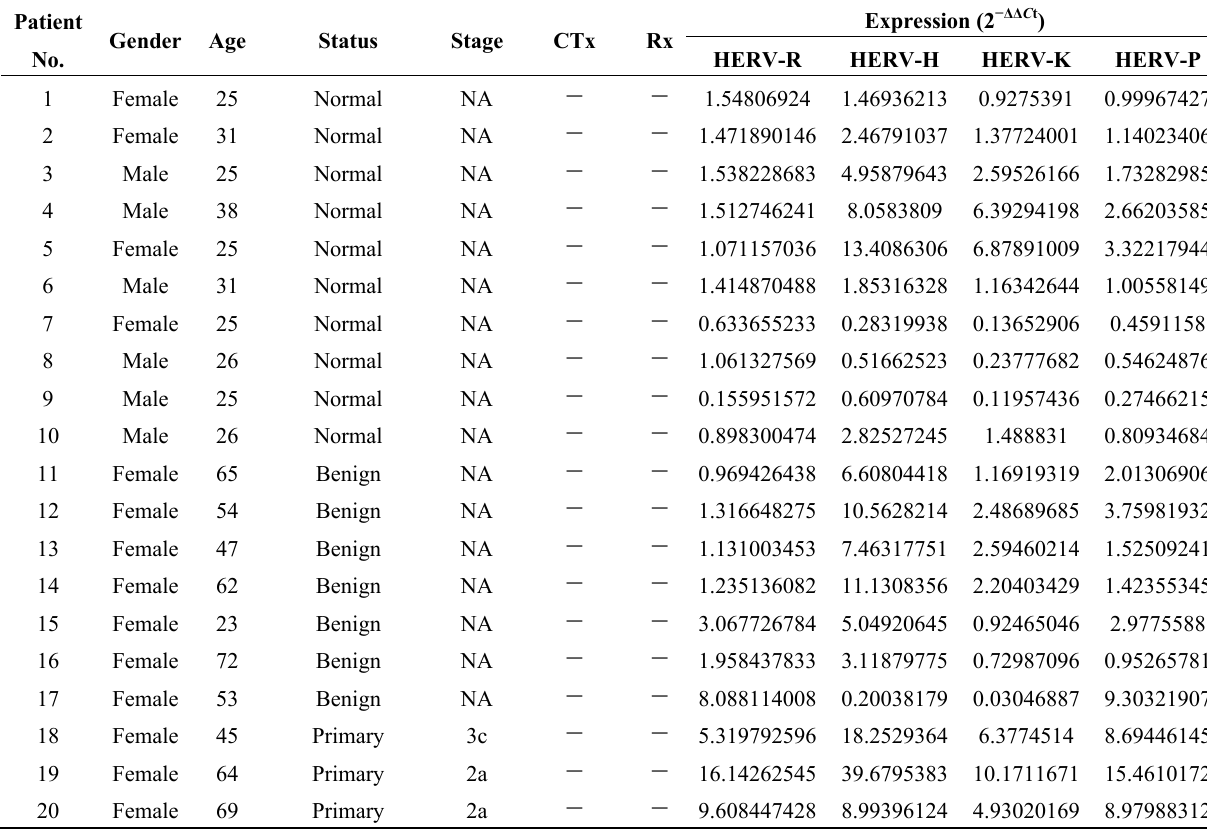
Table 1. Patients information and expressions of HERV env